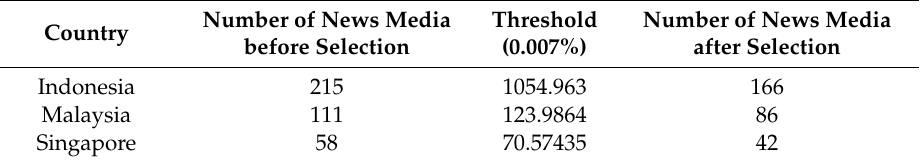
Table 2. Number of online news media before and after edge